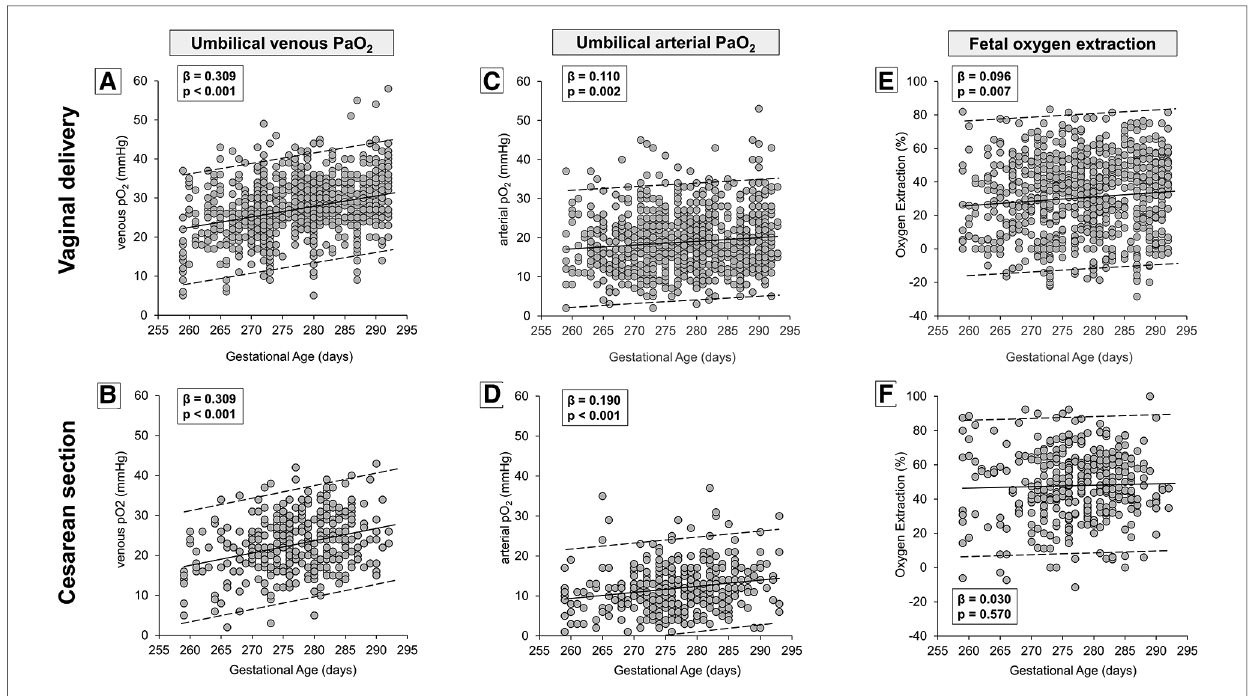
FIGURE 3 Scatter plots with regression lines and 95% prediction intervals representing umbilical-cord oxygenation status [venous PaO 2 , panel A ( n =860) — panel B ( n =373); arterial PaO 2 , panel C ( n =811) — panel D ( n =370); fetal oxygen extraction, panel E ( n =795) — panel F ( n =363)] strati fi ed by modality of